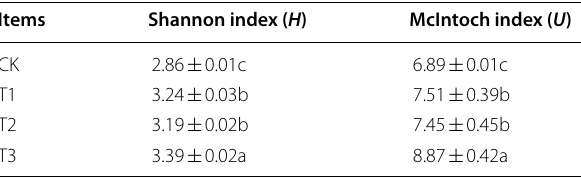
Different small letters in the same column meant significant differences among treatments according to Duncan’s multiple range test at P < 0.05